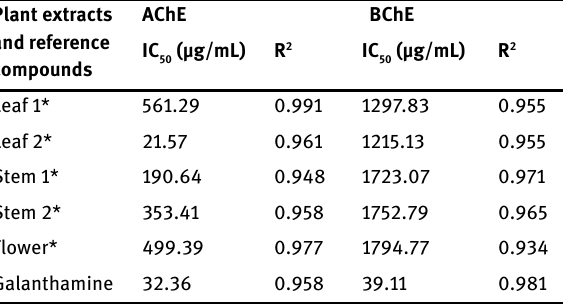
Table 1: Acetylcholinesterase and butyrylcholinesterase inhibitory activity of different part extracts of M. sativa